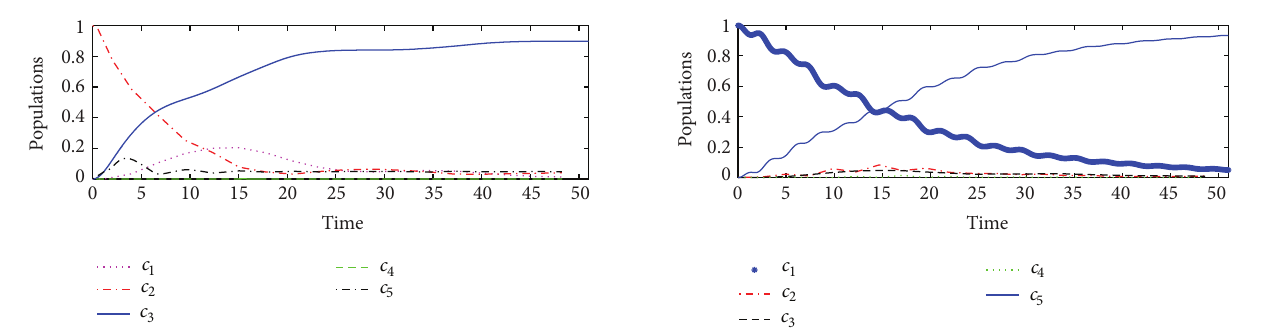
Figure 2: The population of the system state by the Lyapunov control without impulsive control.